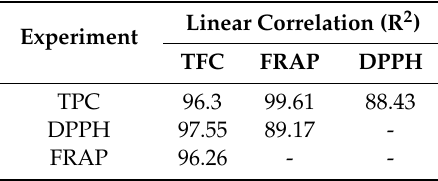
Table 3. Linear correlation between total phenolic and flavonoid contents and antioxidant assays (DPPH and FRAP). Correlation significant at p <